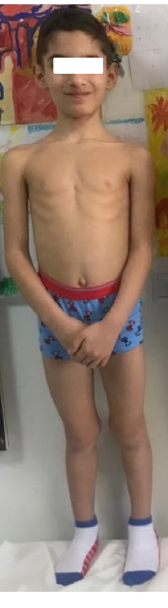
Figure 3. Case report three: eight ‐ years ‐ and ‐ a ‐ half ‐ old boy, diagnosed at seven years with harmo ‐ nious short stature: − 3.2 SD, BMI 3rd percentile, and MPH − 1.03 SD.